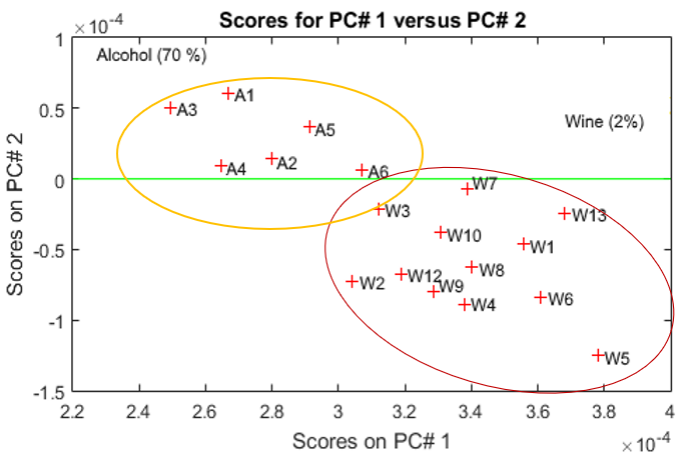
Figure 12. PCA scores plot performed to discriminate the measurements of alcohol (70%) and wine (2%) without temperature modulation.